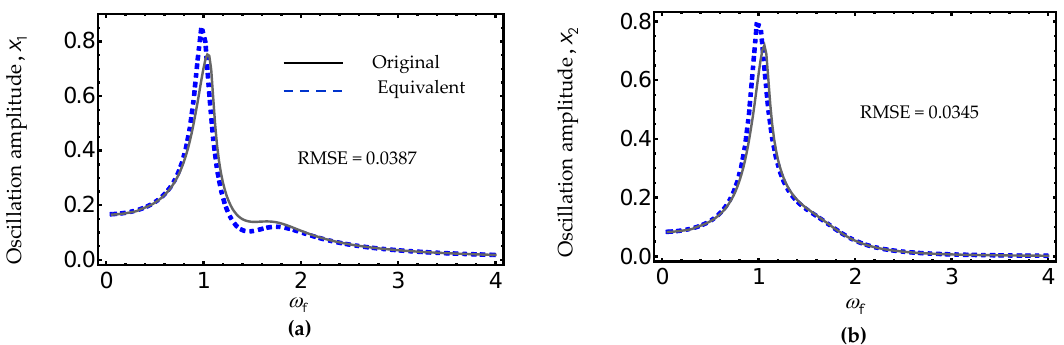
Figure 4. Frequency-amplitude response curves: ( a ) x 1 vs ω f , ( b ) x 2 vs ω f . These were computed from the numerical integration solutions of Equations (29) and (30). The parameter values used to obtain these plots were m 1 = m 2 = 1, k = 1, ε = 0.5 with c = 0.3 and f 1 = 0.25. Here, the black solid lines describe the numerical integration solutions of Equation (30), while the blue dashed lines represent the numerical solutions obtained from Equation (29).